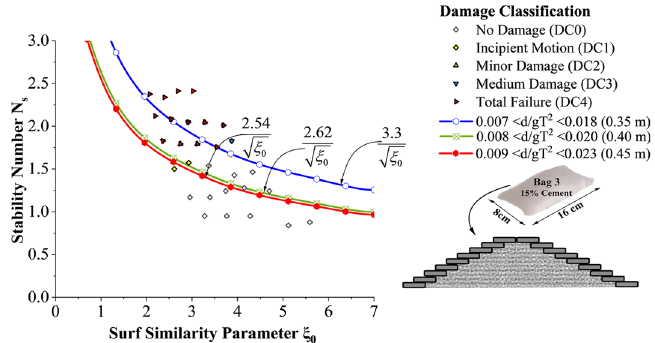
Figure 10. Incipient motion curves for Bag 3 filled with 15% cement, arranged to a single